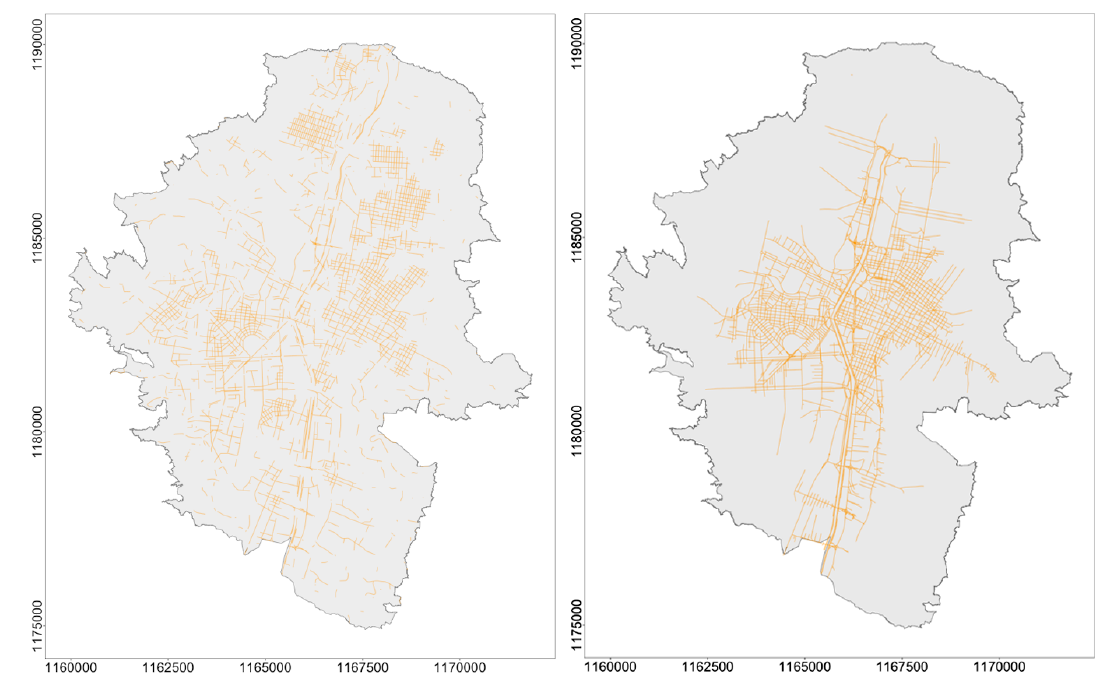
Figure 10. Urban morphological models for Medellín. Formats are as Figure 9. of network sections at which high-value local segments (400m) overlap with high-value global-scale segments (Figure 11). The purpose of this was to observe the ‘potential’ impacts of wider-scale movements on local- scale centralities.